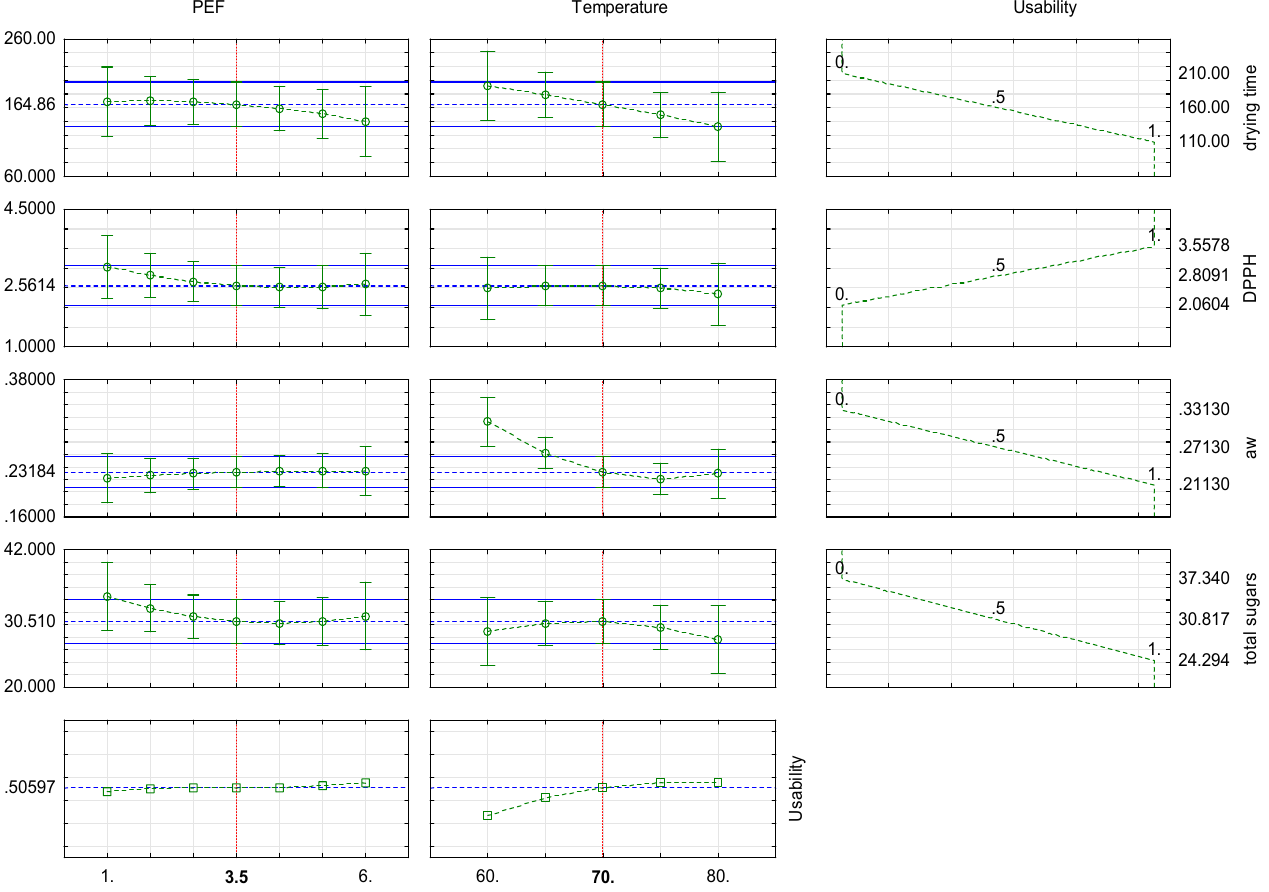
Figure 12. Approximation profiles and usability for dried apple